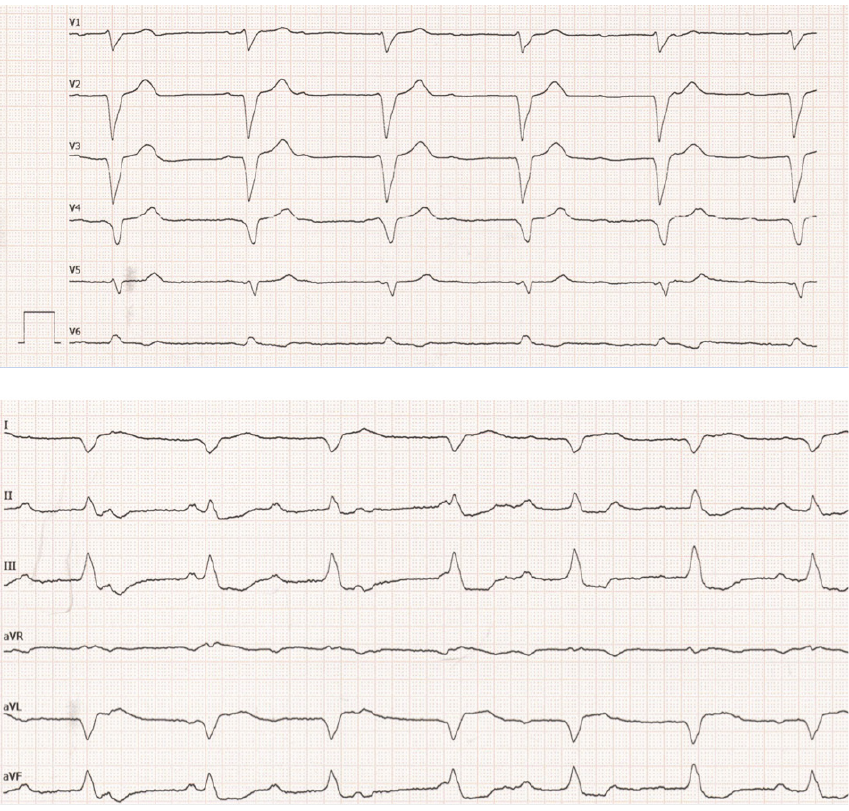
Figure 1: 12 lead ECG upon admission to our center.